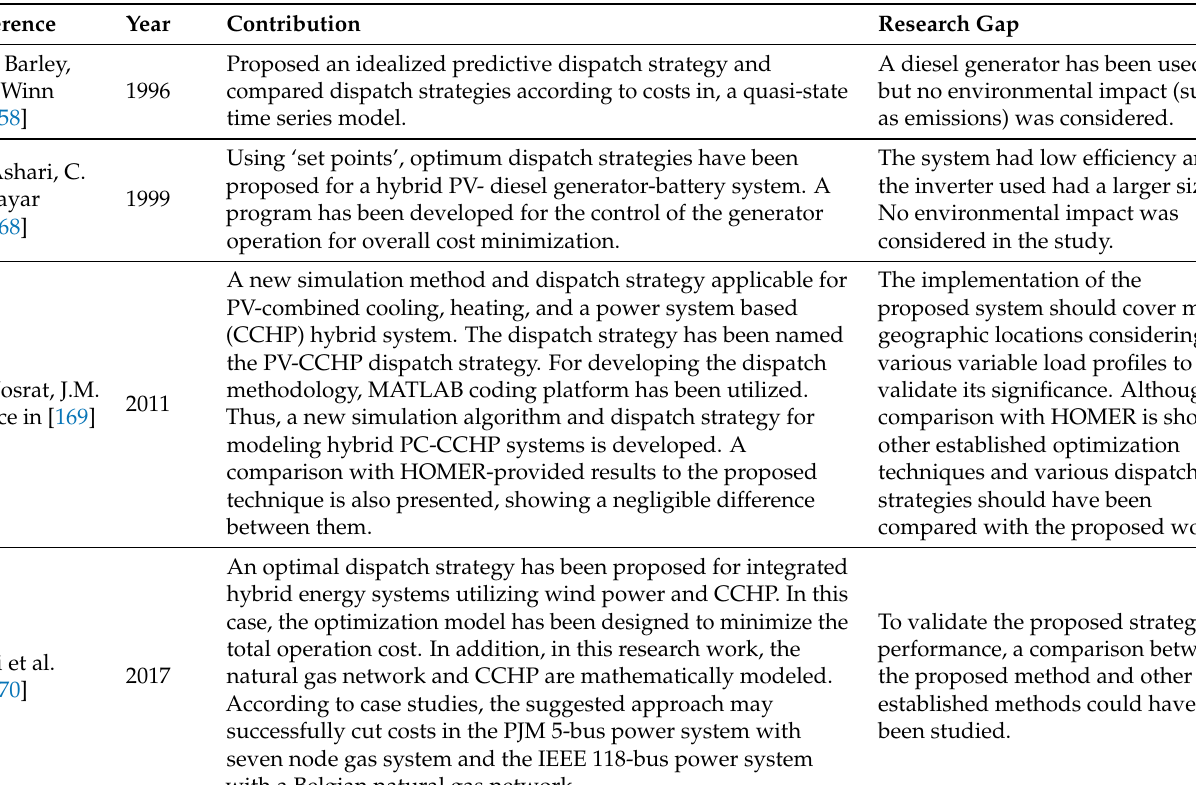
Table 10. A summary for the present state-of-art of the research domain in a dispatch strategy based microgrid design and optimization is summarized in the following table. Table 10. Dispatch strategy oriented research on hybrid